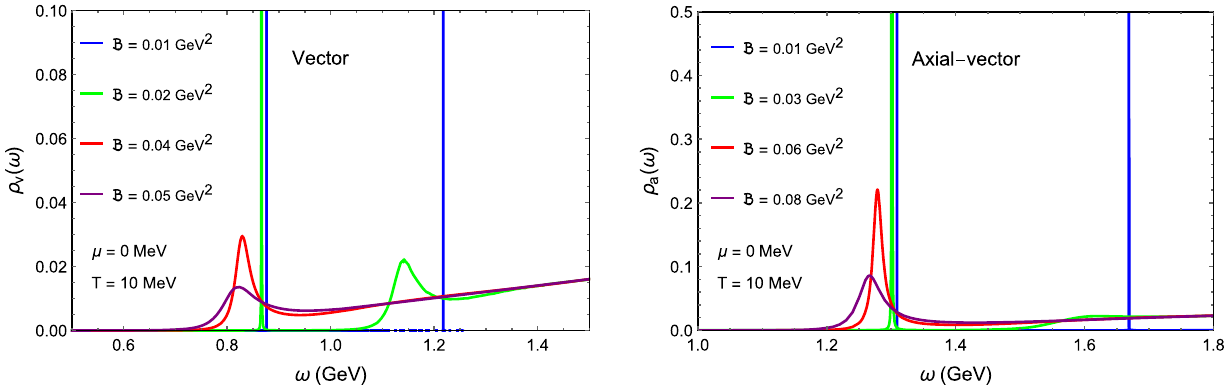
Fig. 6 The spectral functions ρ v (ω) and ρ a (ω) for four different values of B at μ = 0 and T = 10